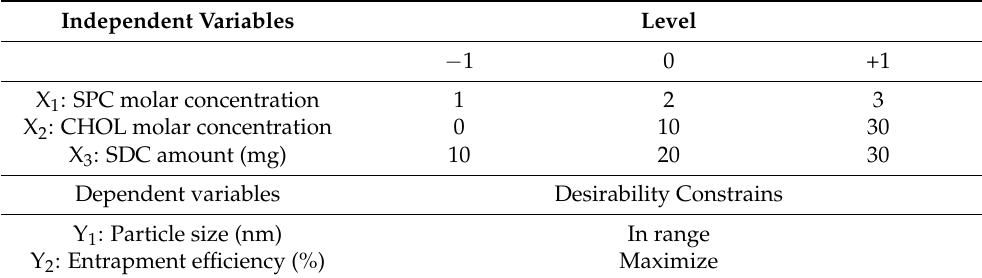
Table 1. Box-Behnken design used for optimization of VDF-loaded bilosomal formulations. Independent Variables